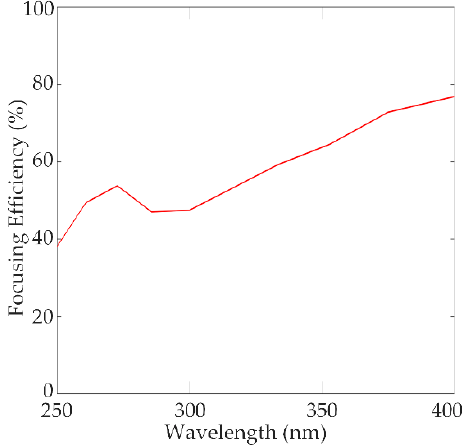
Figure 5. Focusing efficiency of the metalens designed for the broadband UV spectrum 250–400 nm.